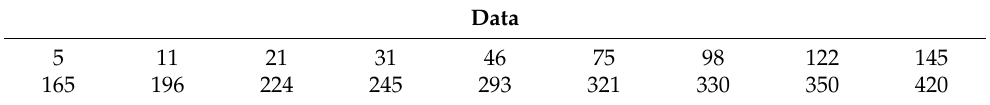
Table 6. Wang [7] Data of 18 electronic devices.